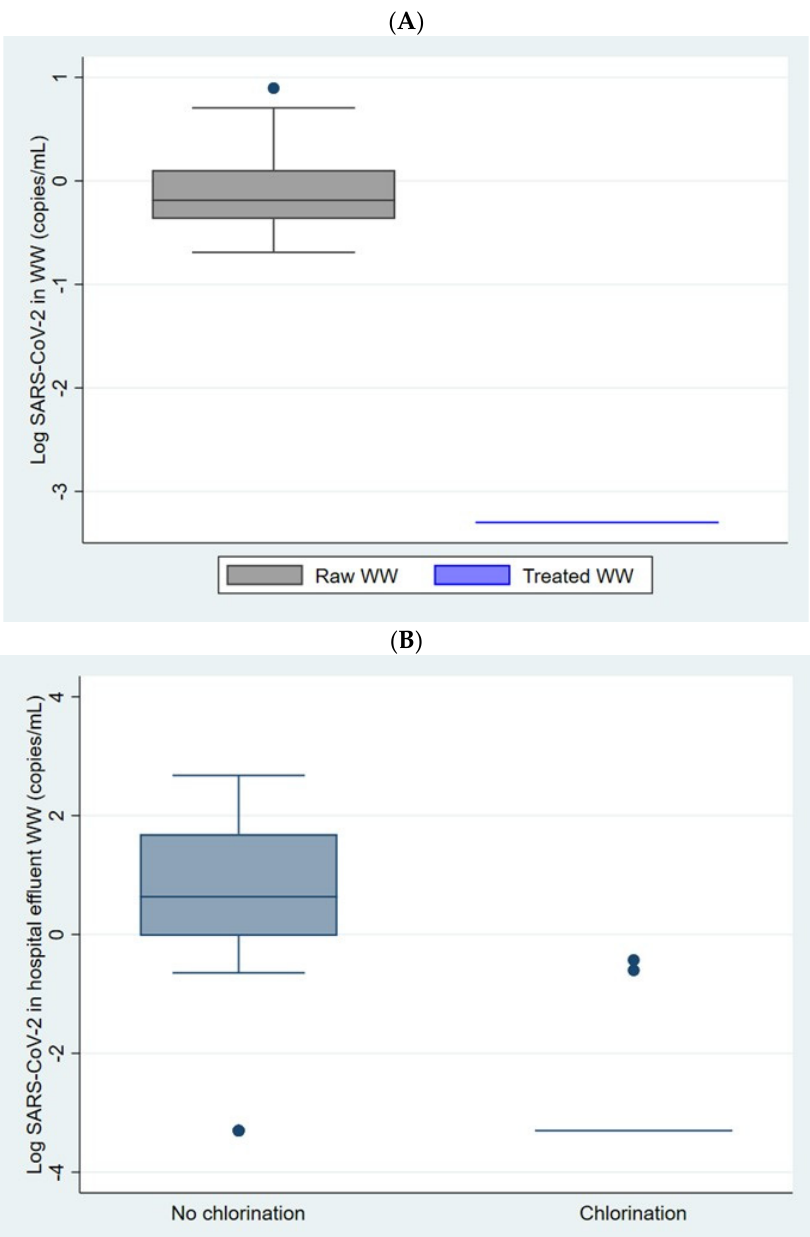
Figure 2. SARS-CoV-2 RNA quantification in 24 h composite samples in ( A ) raw and treated